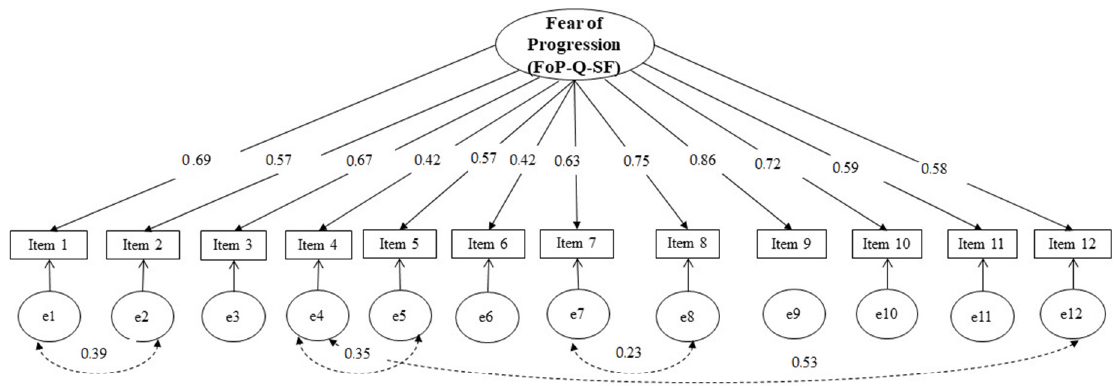
Figure 1. Modified one-factor model for the